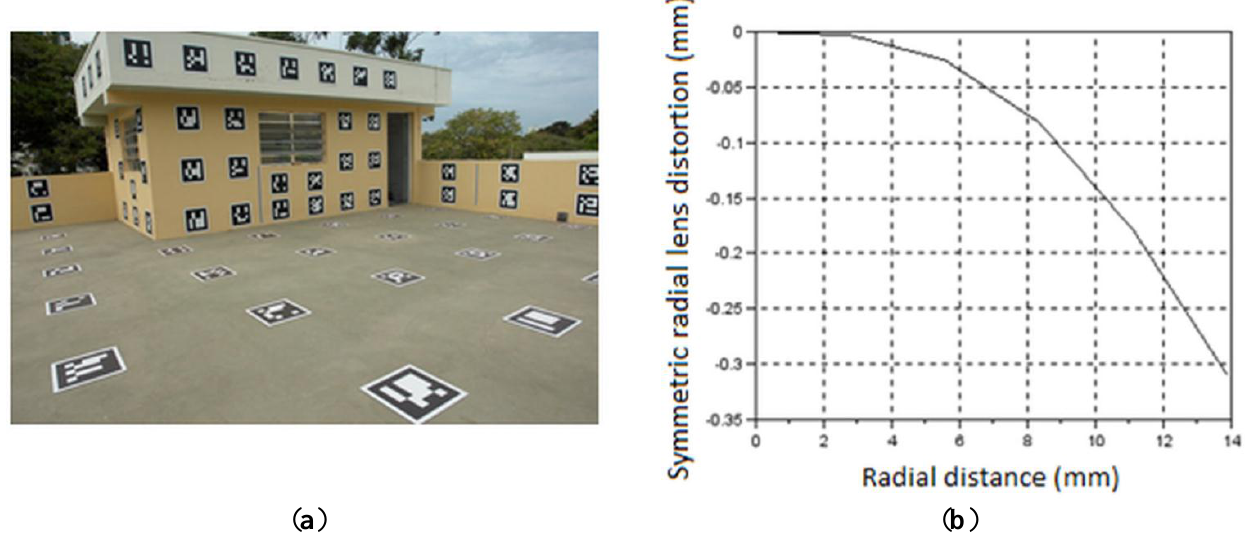
Figure 3 . ( a ) Symmetric radial lens distortion effect and ( b ) Terrestrial calibration